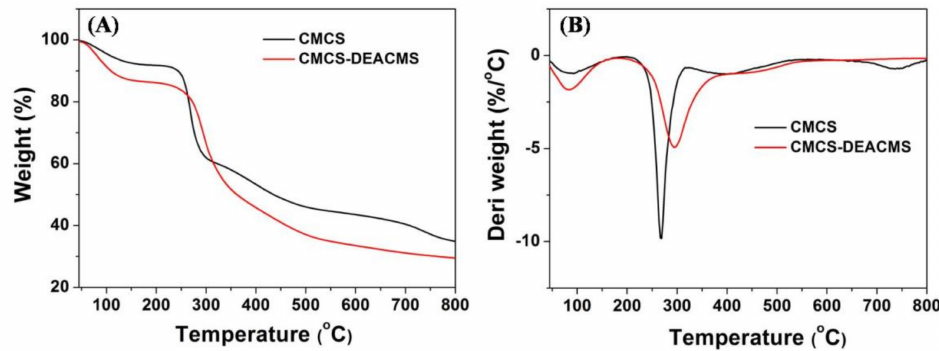
Figure 2. ( A ) TGA and ( B ) DTG curves of CMCS and